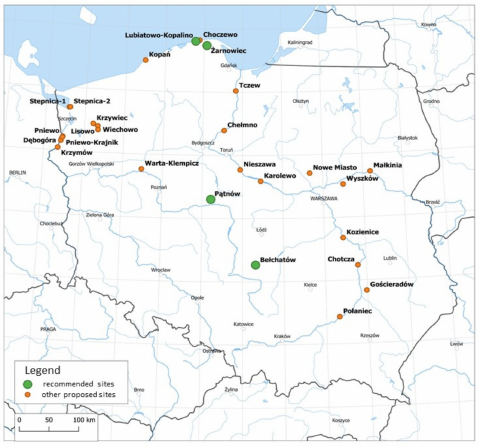
Figure 1. The potential sites of nuclear power plants in Poland. Source: